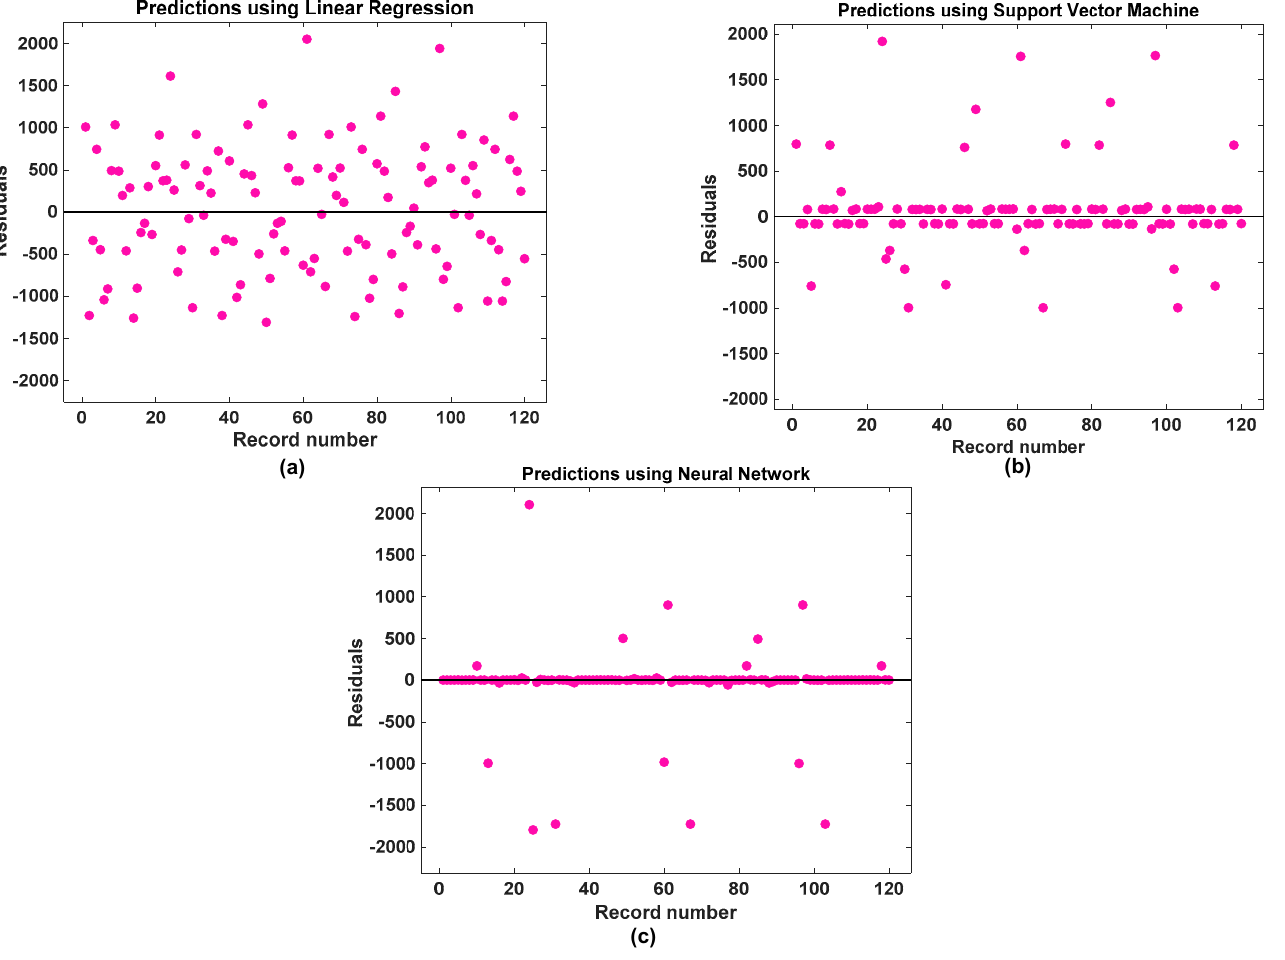
Figure 9. Residual plots of ( a ) Linear Regression (quadratic), ( b ) Support Vector Machine, and ( c ) Artificial Neural Network models.